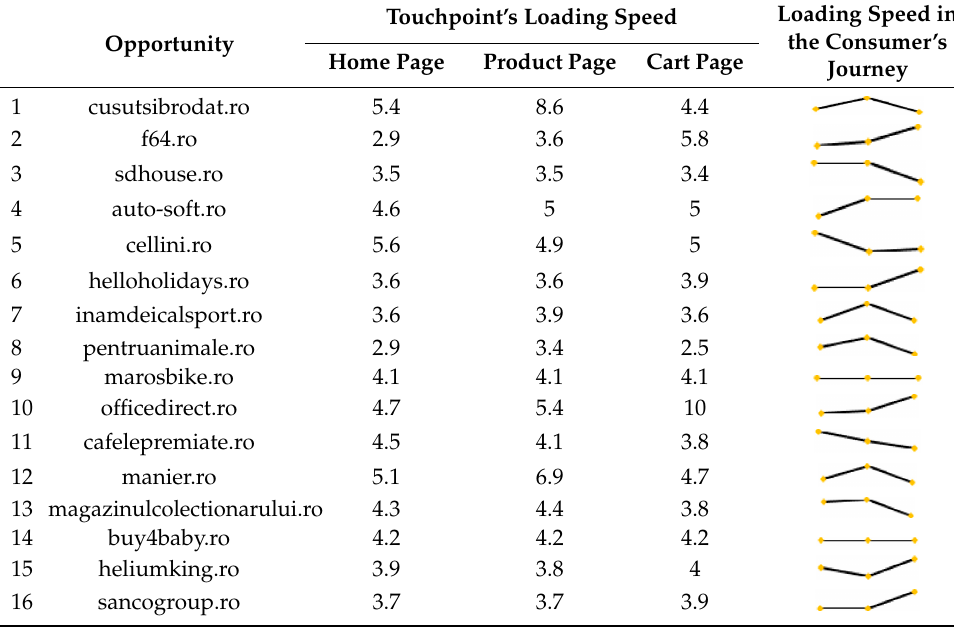
Table A1. The loading speed in the consumer’s journey.